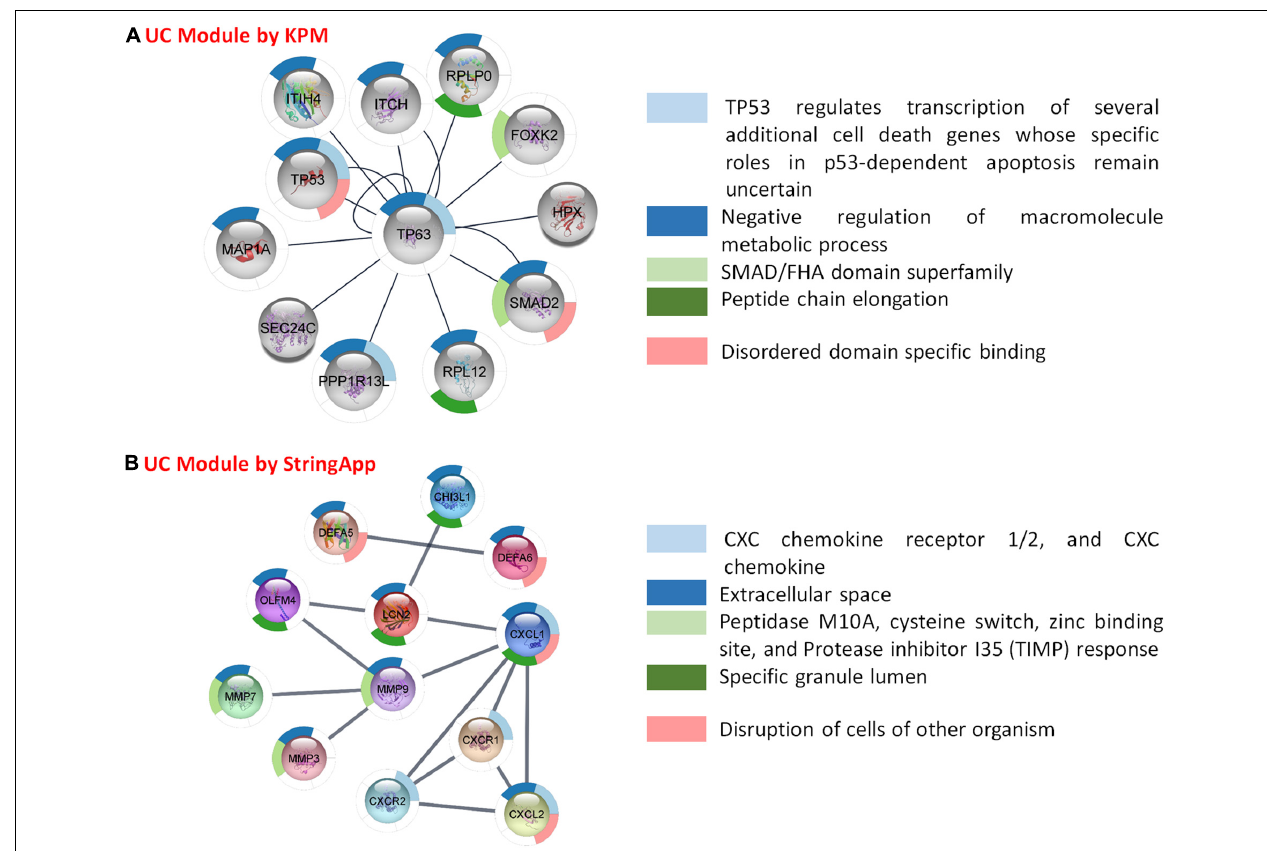
FIGURE 7 | Functional analysis and comparison of UC-specific modules. (A) UC-specific module by KeyPathwayMiner (KPM) and the top 5 enrichment results based on the p-value. (B) UC-specific module by StringApp and the top 5 enrichment results based on the